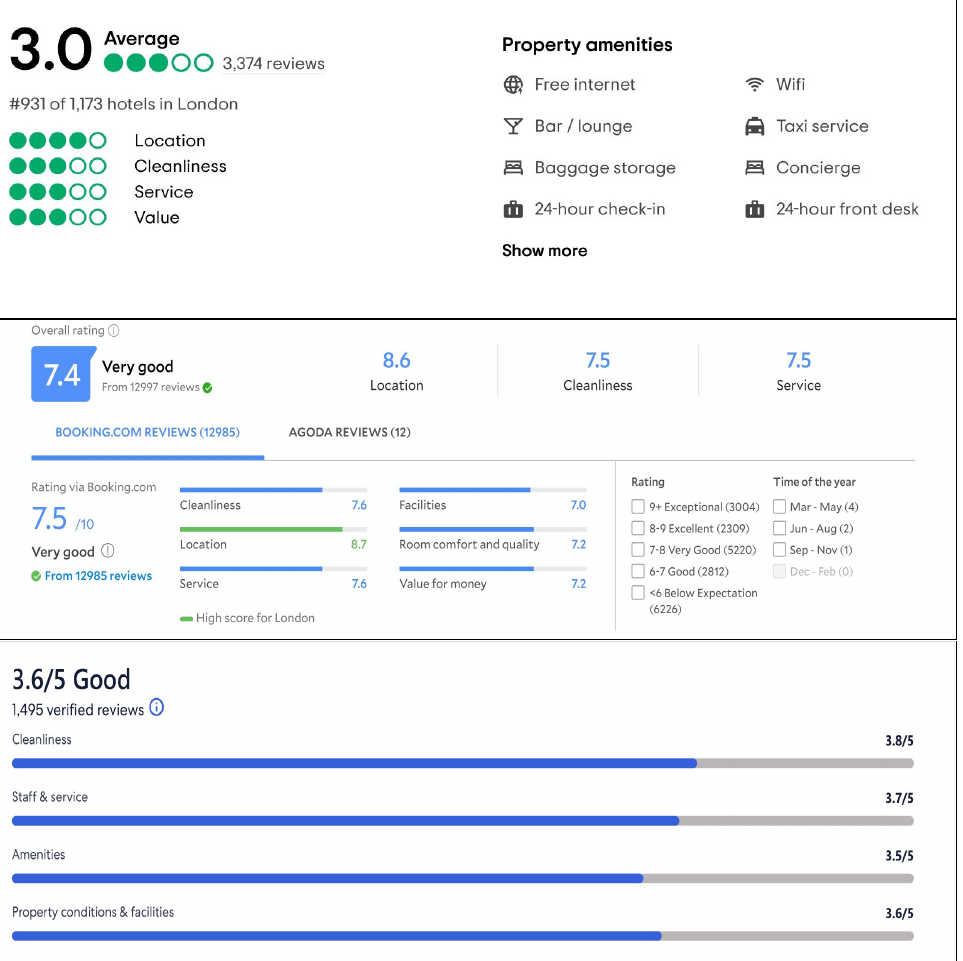
Figure 1. A comparative analysis of the overall ratings of a specific hotel for three different hotel booking websites, i.e., Tripadvisor.com (accessed on 29 June 2021), Agoda.com (accessed on 29 June 2021), and Expedia.com(accessed on 29 June 2021) (Image Source: